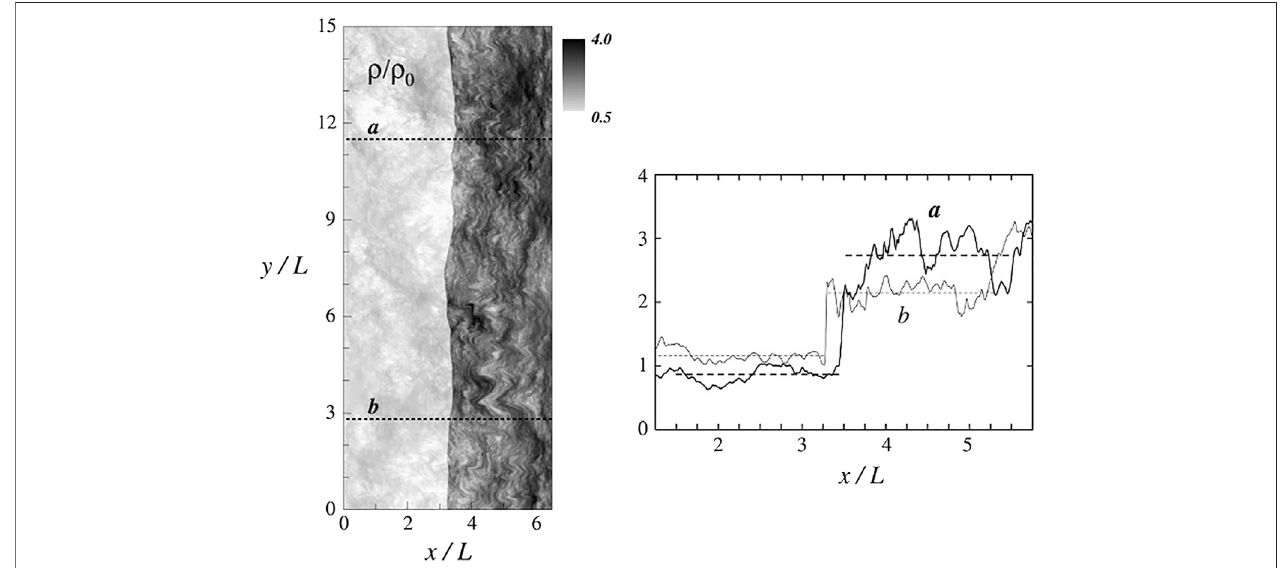
FIGURE 1 | Left panel shows a gray-scale representation of simulated plasma density from a two-dimensional MHD simulation. L is the correlation scale of the turbulent fl uctuations. The shock is rippled as it swept through the turbulent upstream plasma. Right panel shows two cuts for density pro fi les at different y positions indicated on the left panel [adapted from Giacalone and Neugebauer, 2008]. Reproduced by permission of the